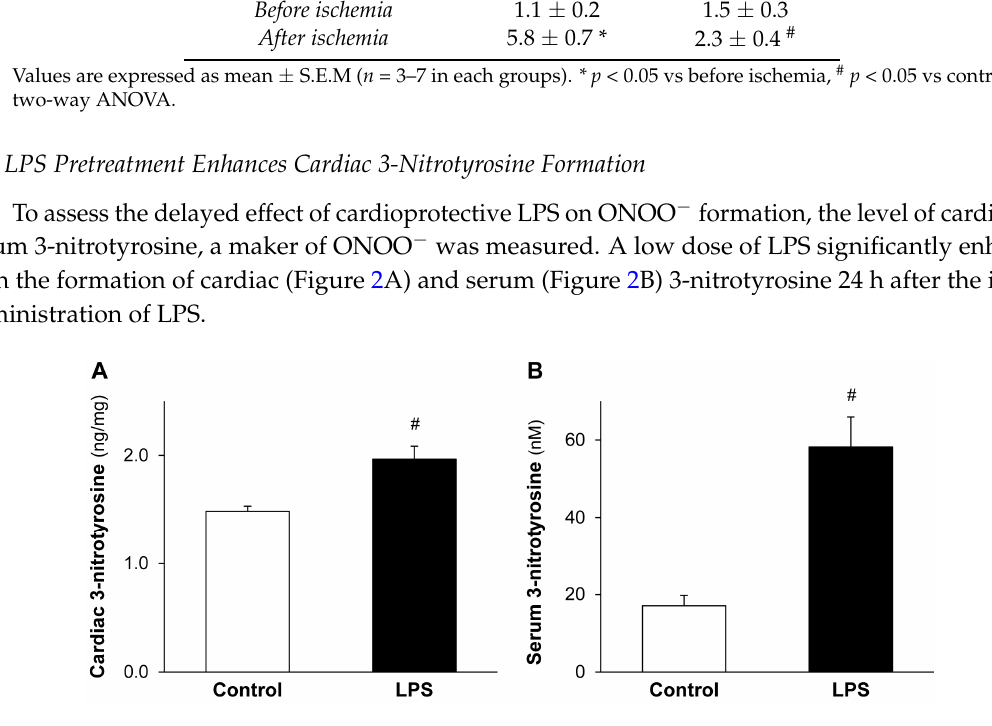
Figure 2. LPS pretreatment enhances cardiac and serum 3-nitrotyrosine formation. Figure